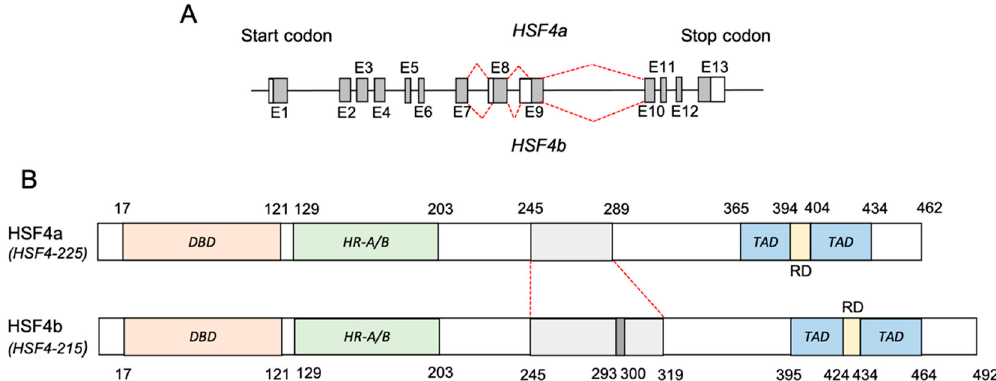
Figure 3. HSF4 gene structure and post-transcriptional modifications. ( A ) The HSF4 gene is comprised of 13 exons, which via alternative splicing within exon eight and nine can give rise to two major HSF4 isoforms: HSF4a (HSF4-225) and HSF4b (HSF4-215). ( B ) HSF4b, the predominant HSF4 transcript, is translated to produce 492 amino acids, 30 amino acids longer than its spliced variant counterpart. Whilst HSF4b functions as a transcriptional activator, HSF4a is reported to act as a transcriptional repressor. DBD: DNA binding domain; HR-A/B: oligomerization domain; RD: regulatory domain; TAD: transactivation